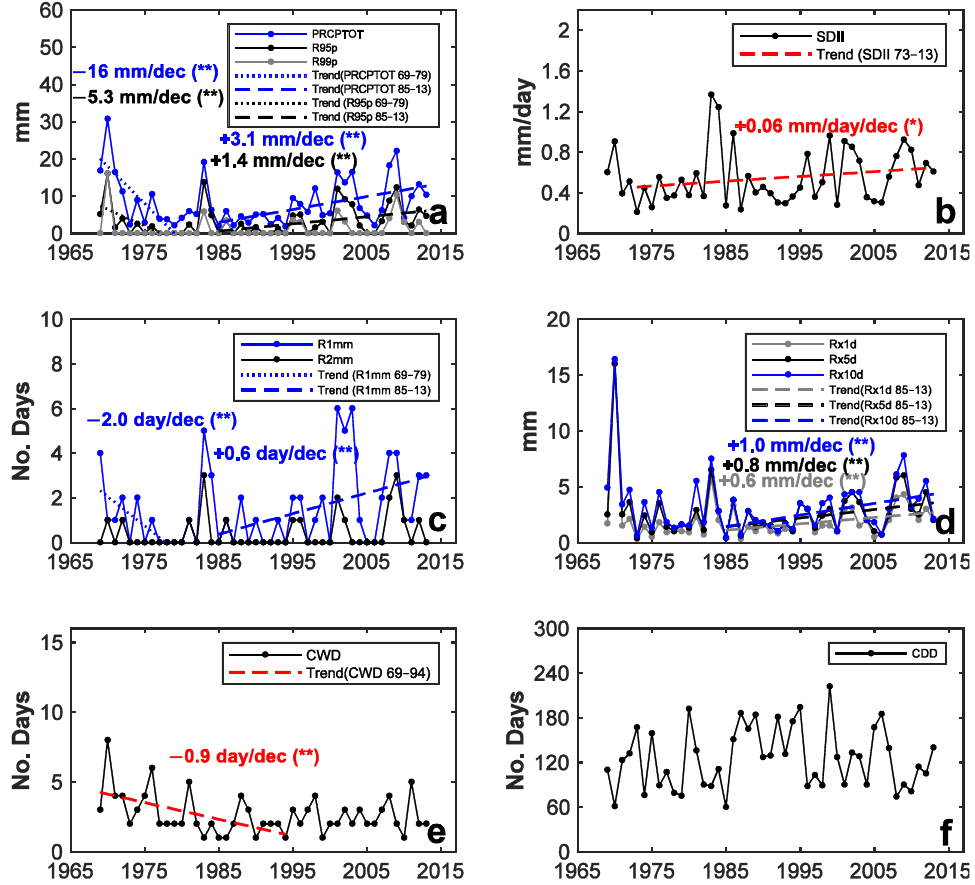
Figure 10. Linear trends of extreme precipitation indices: ( a ) PRCPTOT, R95p, R99p; ( b ) SDII; ( c ) R1mm, R2mm; ( d ) Rx1day, Rx5day, Rx10day; ( e ) CWD; and ( f ) CDD. PP > 0.1 mm were applied to identify a day with precipitation. HU station. ** Statistically significant trends at the 95% confidence level ( p < 0.05). * Statistically significant trends at the 90% confidence level ( p < 0.10).